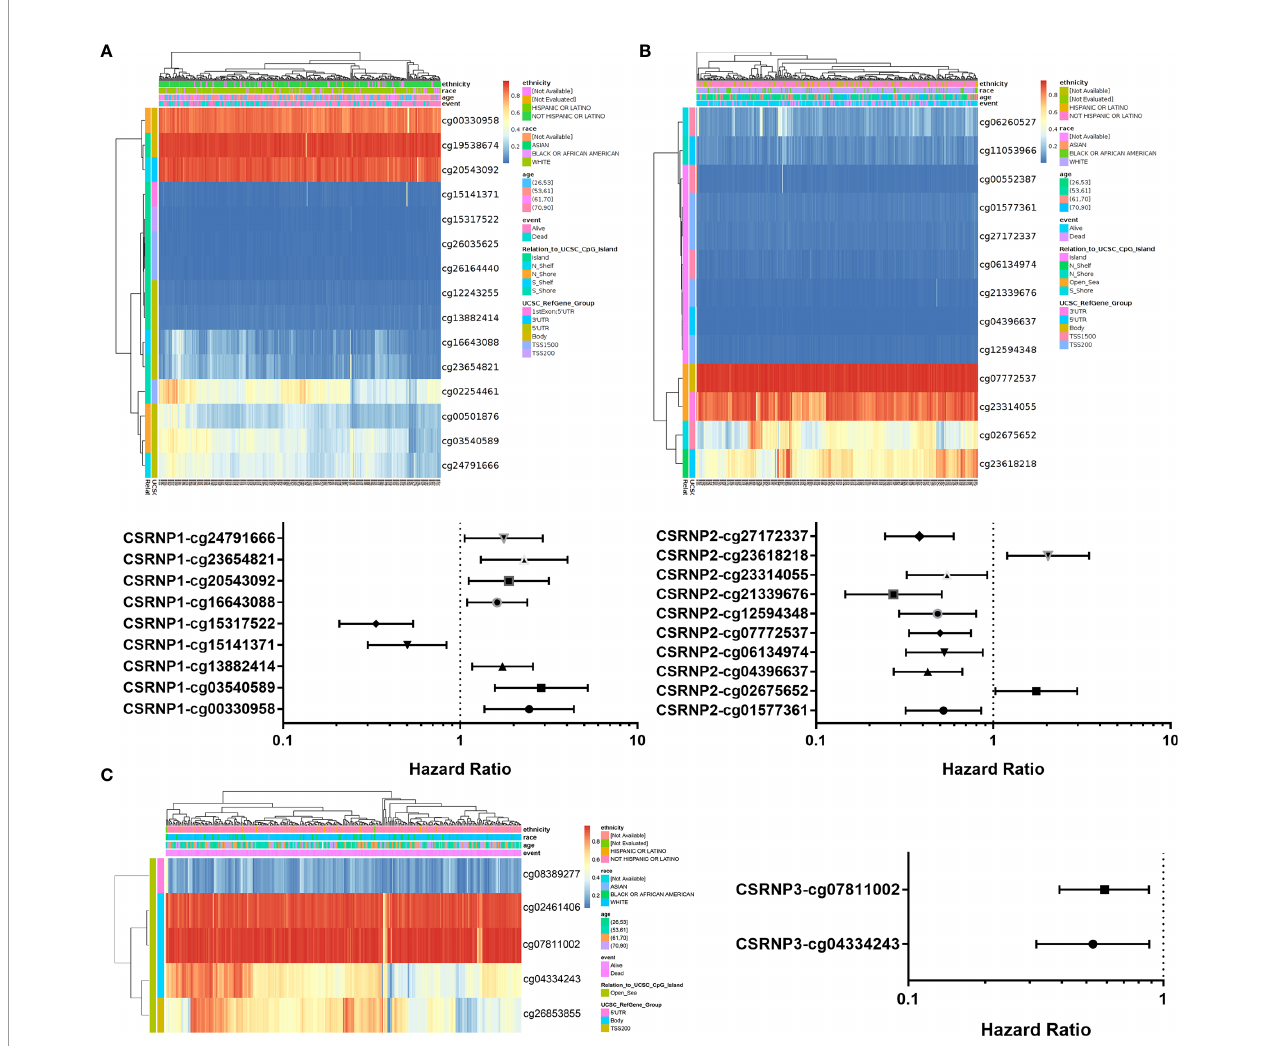
FIGURE 6 | DNA methylation analysis of CSRNP family members using MethSurv. The DNA methylation clustered expression and forest plot of CSRNP1 (A) , CSRNP2 (B) , and CSRNP3 (C) . Red to blue scale indicates high to low expression. Various colorful side boxes were used to characterize the ethnicity, race, age, event, and relation to UCSC_CpG_island and